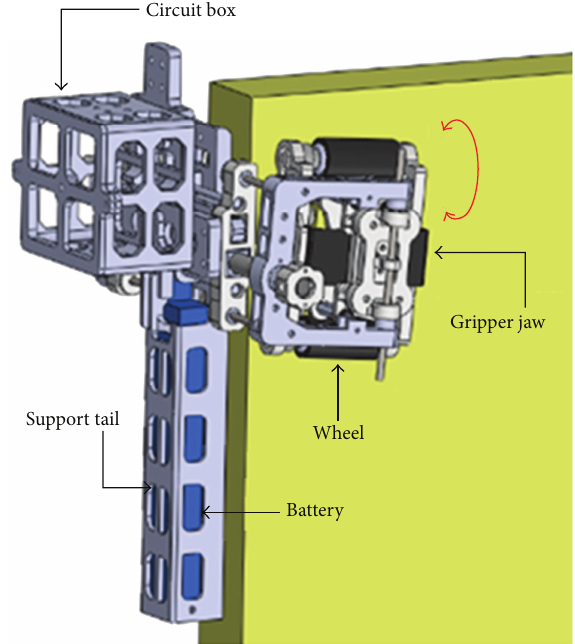
Figure 2: The design of